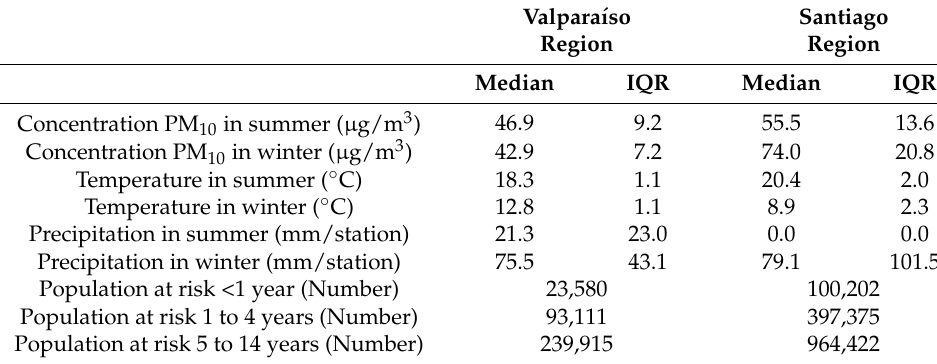
Table 1. Air pollution in summer or winter seasons, meteorological conditions and number of total populations of the Regions of Valpara í so and Santiago, from 2010 to